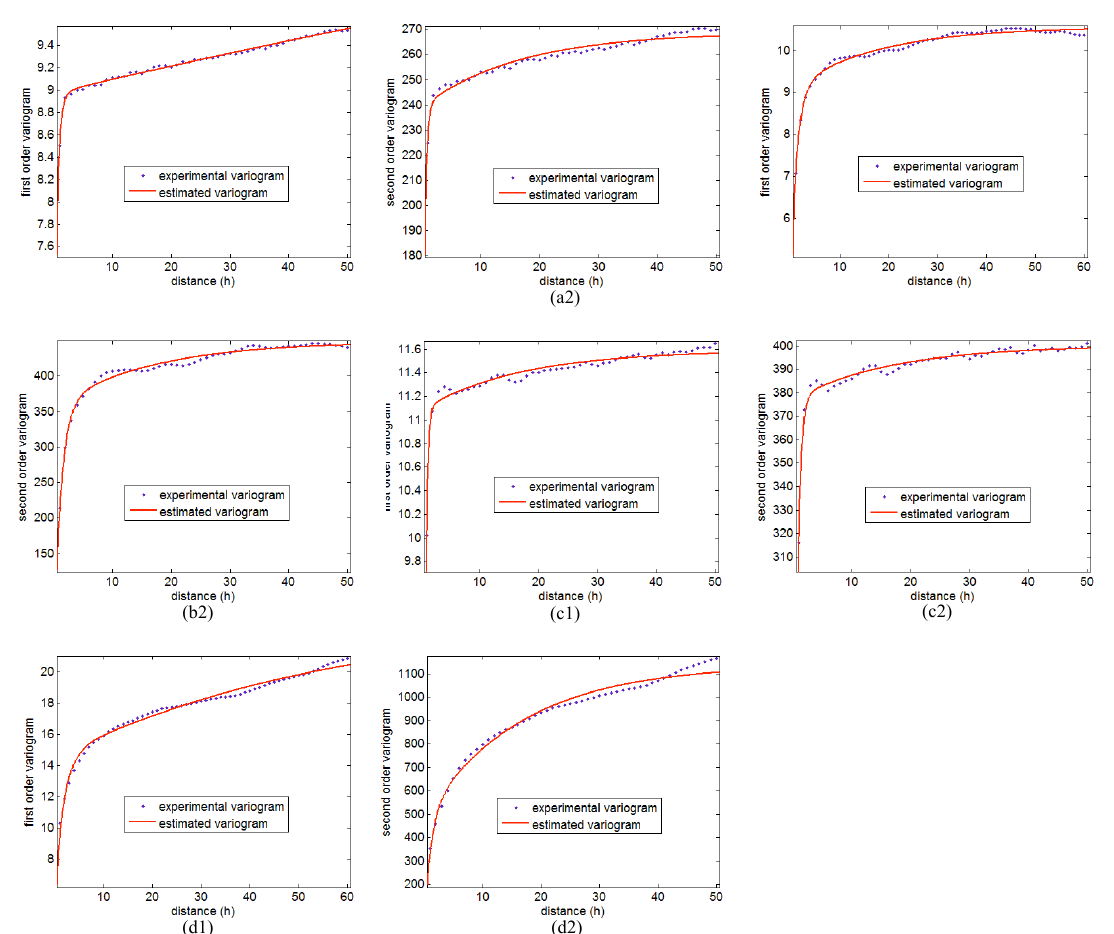
Fig. 12 Result of the estimation of the first-order and second-order variograms from samples (Fig.